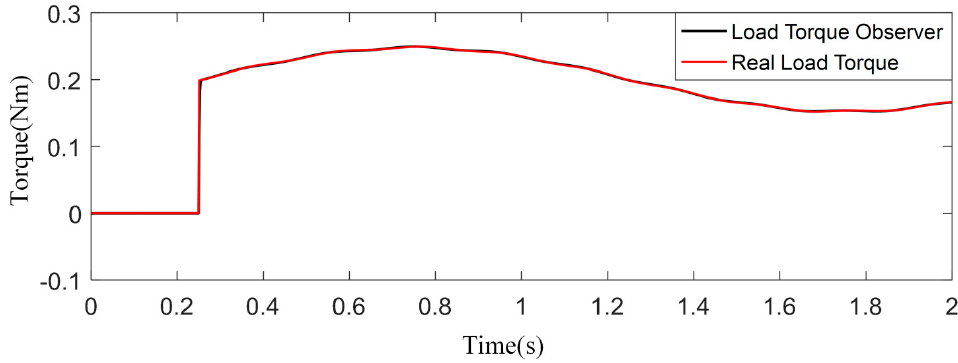
Figure 8. The ESO estimated unknown disturbance of CADRC and MADRC in the speed loop.